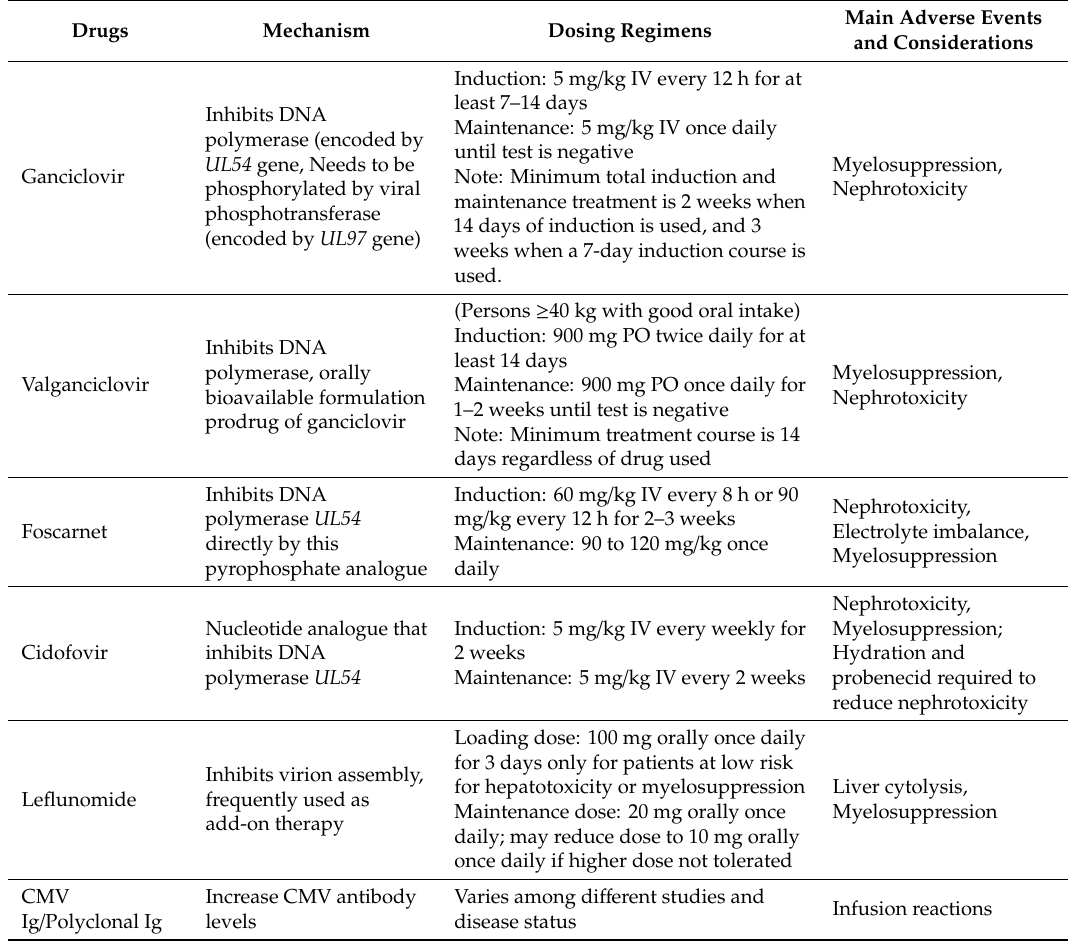
Table 1. Standard therapies against